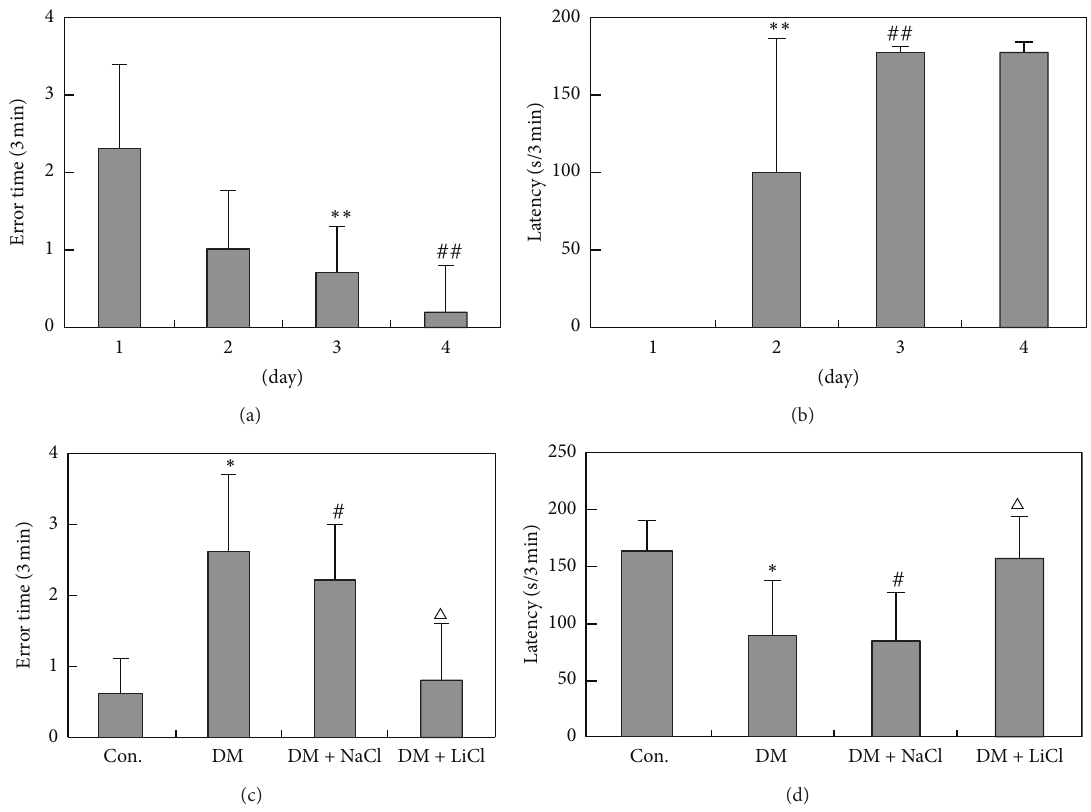
Figure 7: Step-down electronic inhibitory avoidance task. ∗ 𝑃 < 0.05 , # 𝑃 < 0.05 versus Con. group, △ 𝑃 < 0.05 versus DM group. (a) The error time before modeling. The error time reached the similar time level after the rats were trained for 4 d. ∗∗ 𝑃 < 0.01 , ## 𝑃 < 0.01 versus 1d. (b) The latency before modeling. The latency was increased after the rats were trained for 3 d and 4 d. ∗∗ 𝑃 < 0.01 , ## 𝑃 < 0.01 versus 4 d. (c) The error time at 10 days after LiCl administration. The error time increased in DM group but decreased in group with LiCl administration for 10 days. ∗ 𝑃 < 0.05 , # 𝑃 < 0.05 versus Con. group, △ 𝑃 < 0.05 versus DM group. (d) The latency at 10 days after LiCl administration. The latency decreased in DM group but increased in group treated with LiCl administration for 10 days. ∗ 𝑃 < 0.05 , # 𝑃 < 0.05 versus Con, △ 𝑃 < 0.05 versus